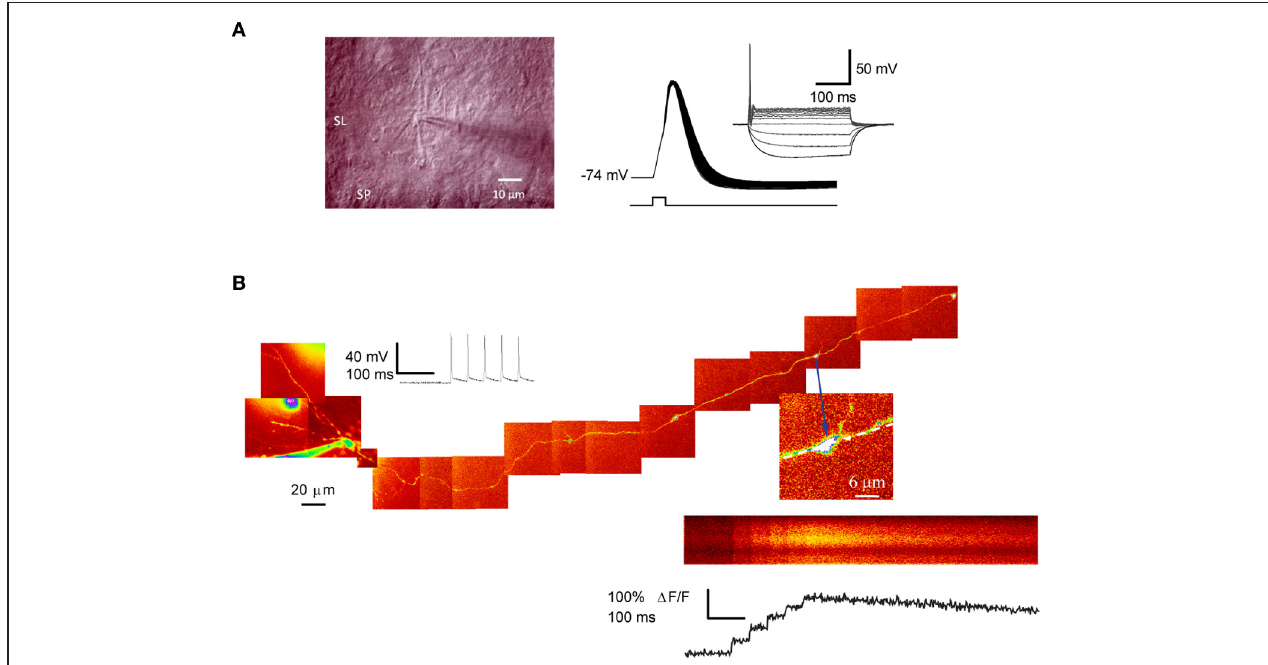
FIGURE 1 | Patch-clamp recording and 2-photon excitation fluorescence imaging from single giant mossy fiber boutons. (A) Left, IR–DIC photomicrograph of a putative mossy fiber bouton in juxtaposition with a dendrite located in stratum-lucidum. Right: action potentials evoked by a single depolarizing current step (1nA, 0.5ms) repeated at 50Hz. Note the spike broadening. Inset shows the I–V relation ( − 30 to 60pA, 300ms; 10pA